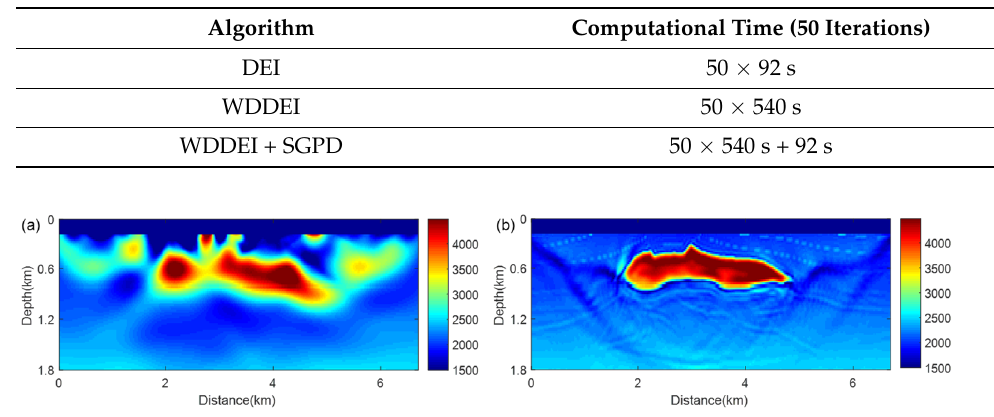
Figure 13. Further discussion about the DEI result. ( a ) DEI result with 10 more iterations than Figure 7a. ( b ) SGPD + FWI result based on Figure 6d.